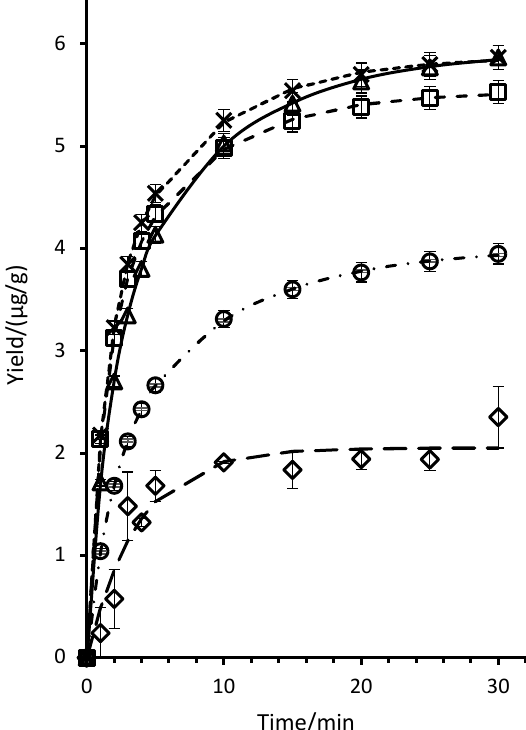
Figure 5. The extraction progress plot of β-asarone at solid-to-solvent ratio 1:100 with sonication power of 70 (□), 50 (×), 30% (∆), and in the absence of sonication, with the presence of temperature ( ○ ) and without (◊). The lines were plotted with the calculated value according to Equation (1) for sonication power of 70 (dashed line), 50 (dotted line), 30% (straight line), and in the absence of sonication with the presence of temperature (dash-dot line) and without (long dashed line).